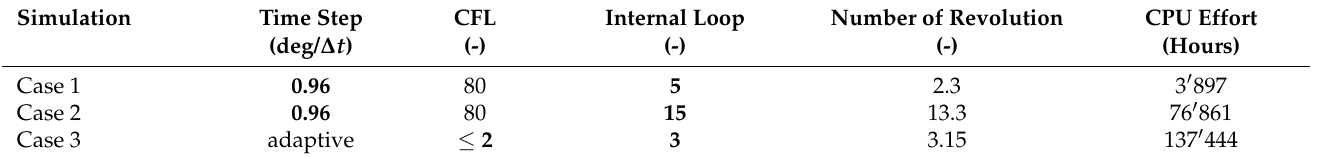
Table 1. Parameters set for the time integration. Bold terms refer to the imposed values by the user.